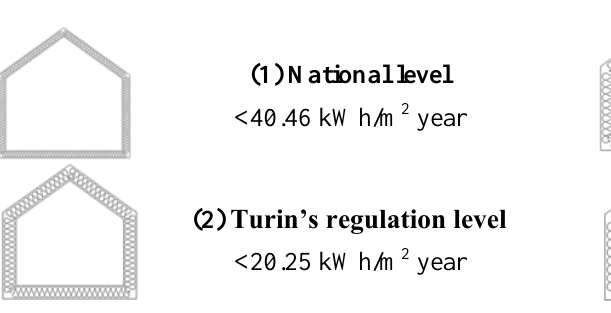
Figure 3. Design levels for building envelope energy performances.